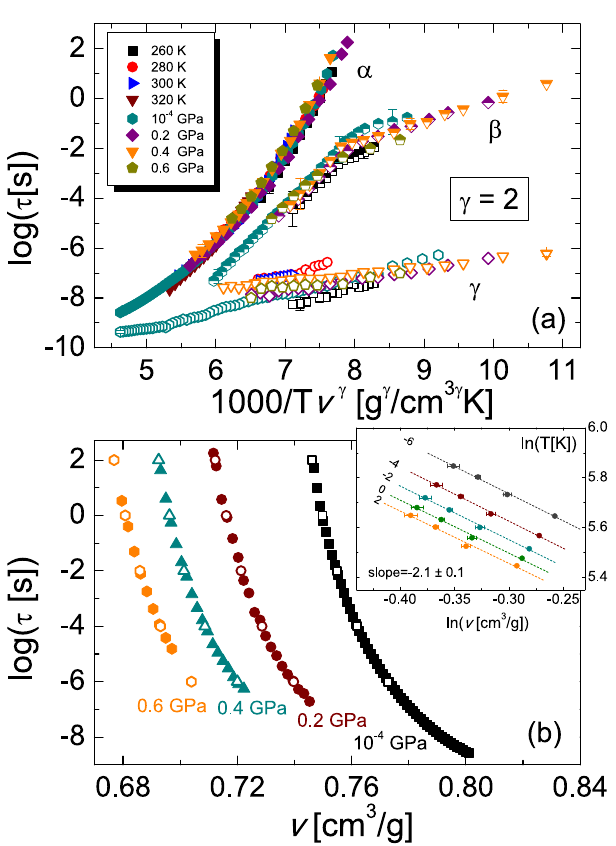
Figure 6. ( a ) Thermodynamic scaling plot of the relaxation times of all three dynamic processes, as function of the quantity 1000/ Tv γ with γ = 2 ( v is the specific volume calculated for each ( P , T ) pair by means of the experimental equation of state, Eq. 6). Representative error bars are indicated. ( b ) Plot of Log( τ α ) as function of v for all four isobaric measurements. Filled markers correspond to the experimental data of Fig. 2(a). Open markers represent, for each isobar, the calculated value of v at selected relaxation times (namely τ α = 10 − 6 , 10 − 4 , 10 − 2 , 10 0 and 10 2 s). Inset: plot of ln( T ) vs ln( v ) for all four isobaric measurements (markers), for the five different isochronal conditions corresponding to the open markers in the main panel, and corresponding linear fit (dashed